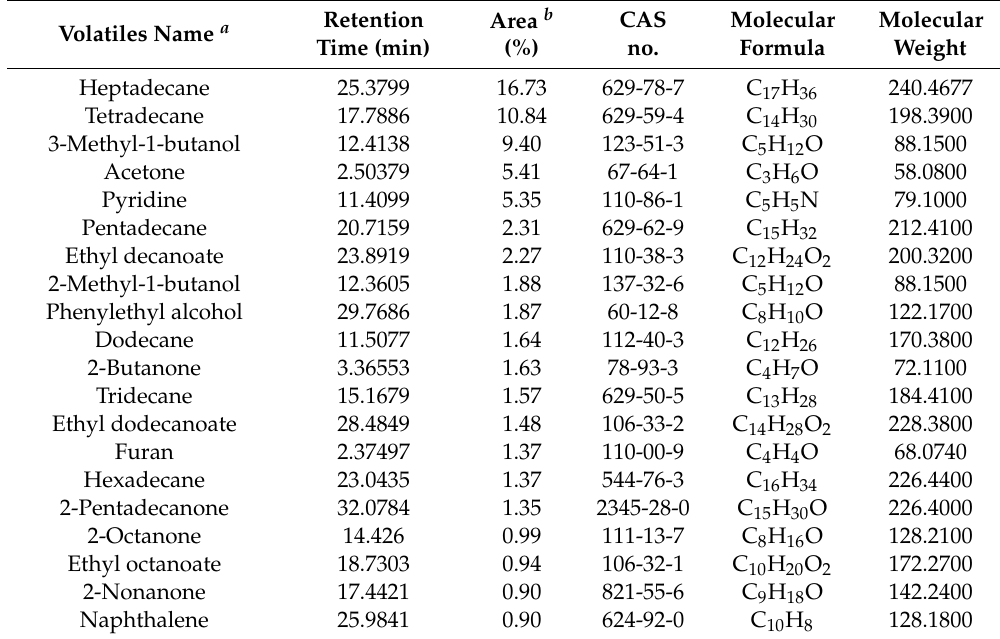
Table 2. HS-SPME / GC-MS analysis of the VOCs produced by S. lavendulae SPS-33.